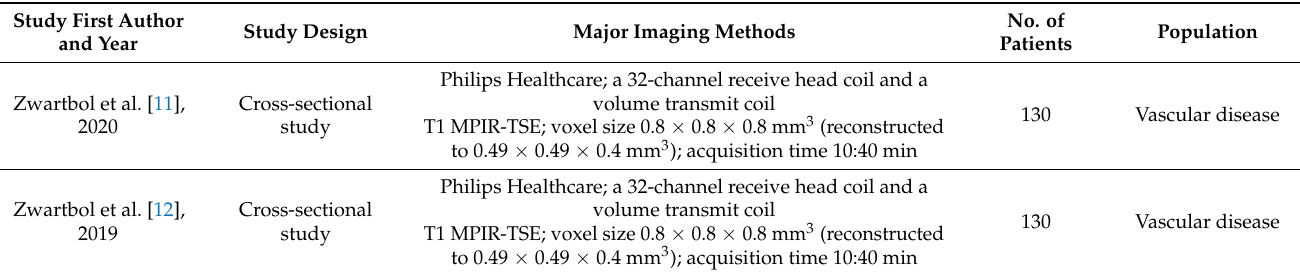
Table 1. Overview of studies evaluating the vessel wall with